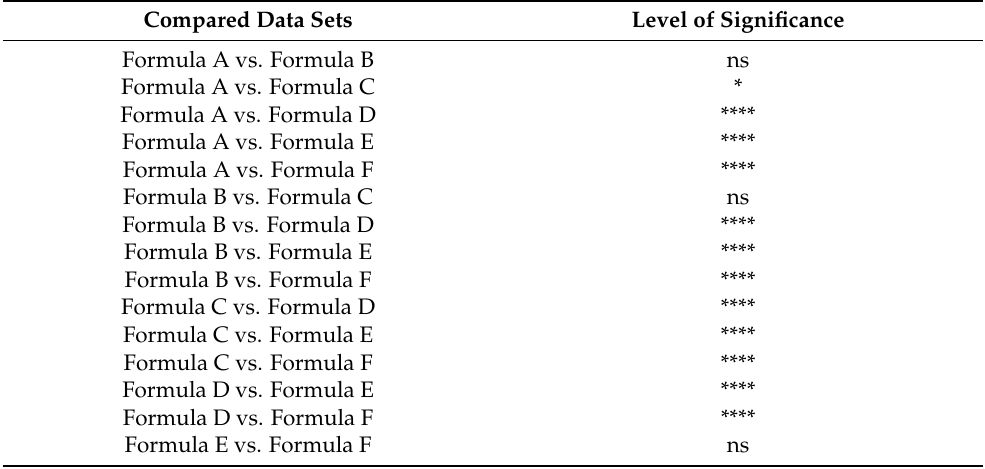
Table 4. Results of Tukey’s multiple comparison test generated by the data of diffusion